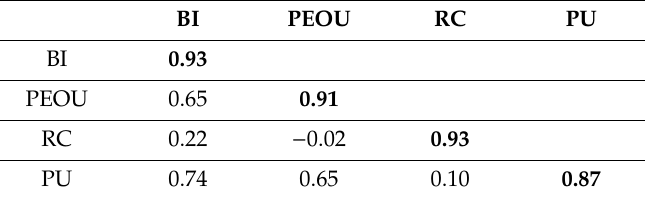
Table 4. Correlation matrix.